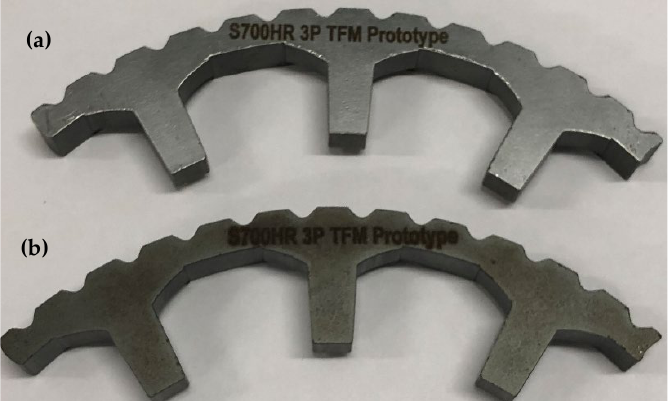
Figure 20. Comparison between TFM segments, ( a ) machine brushed version for burrs, ( b ) manual de-burring.